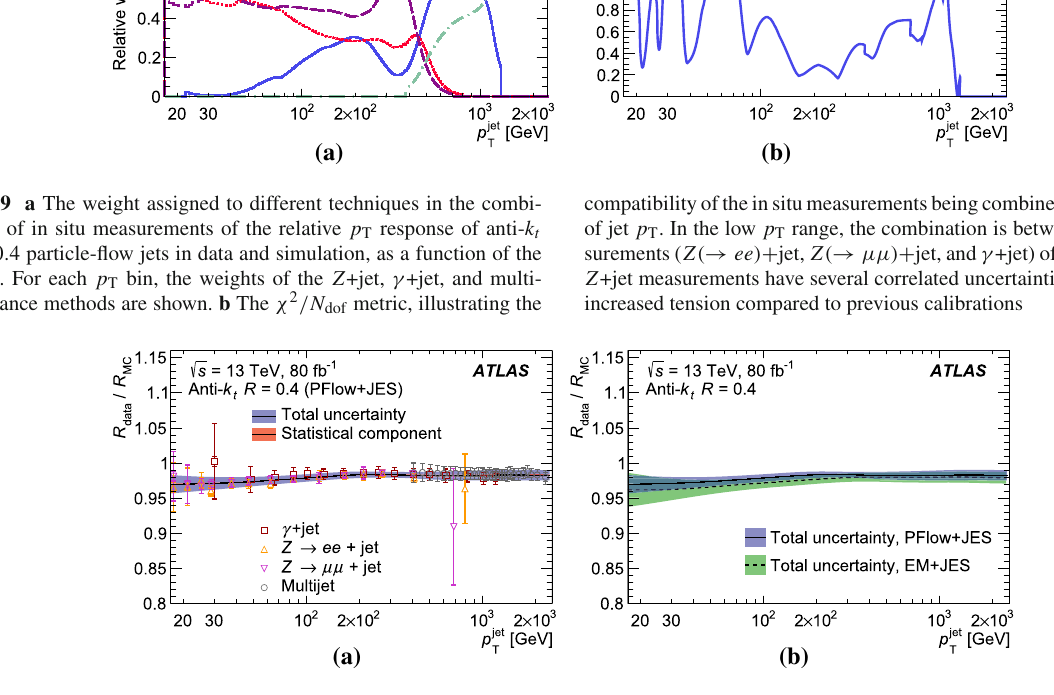
tiesaddedinquadrature). Thefinalcorrectionanditsstatisticalandtotal uncertainty bands are also shown, although the statistical uncertainty is too small to be visible in most regions. b A comparison of the combined correction and its uncertainty for PFlow+JES and EM+JES